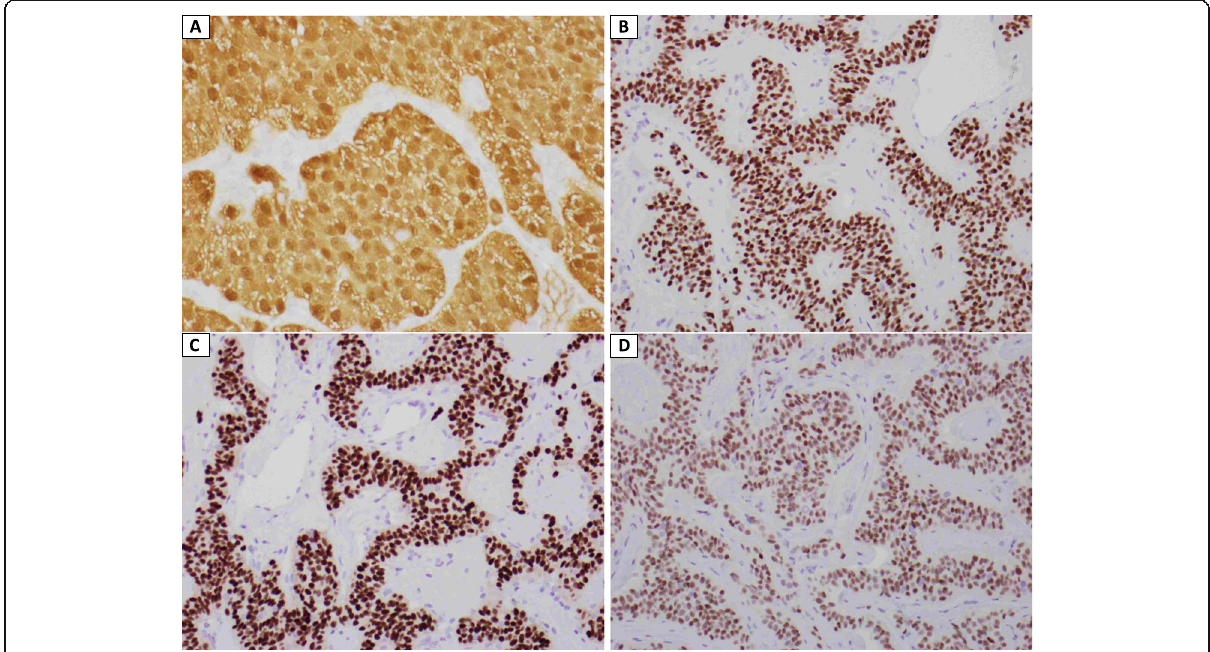
Fig. 2 Immunohistochemical staining in the CMVPTC. A Staining for beta catenin shows nuclear and cytoplasmic staining in many tumor cells (X40). B Strong staining for Estrogen receptor protein is diffusely present in the nuclei of the tumor cells (X20). C Strong staining for Progesterone receptor protein is diffusely present in the nuclei of the tumor cells tumor cells (X20). D Moderate staining for Androgen receptor protein is diffusely positive in the nuclei of the tumor cells